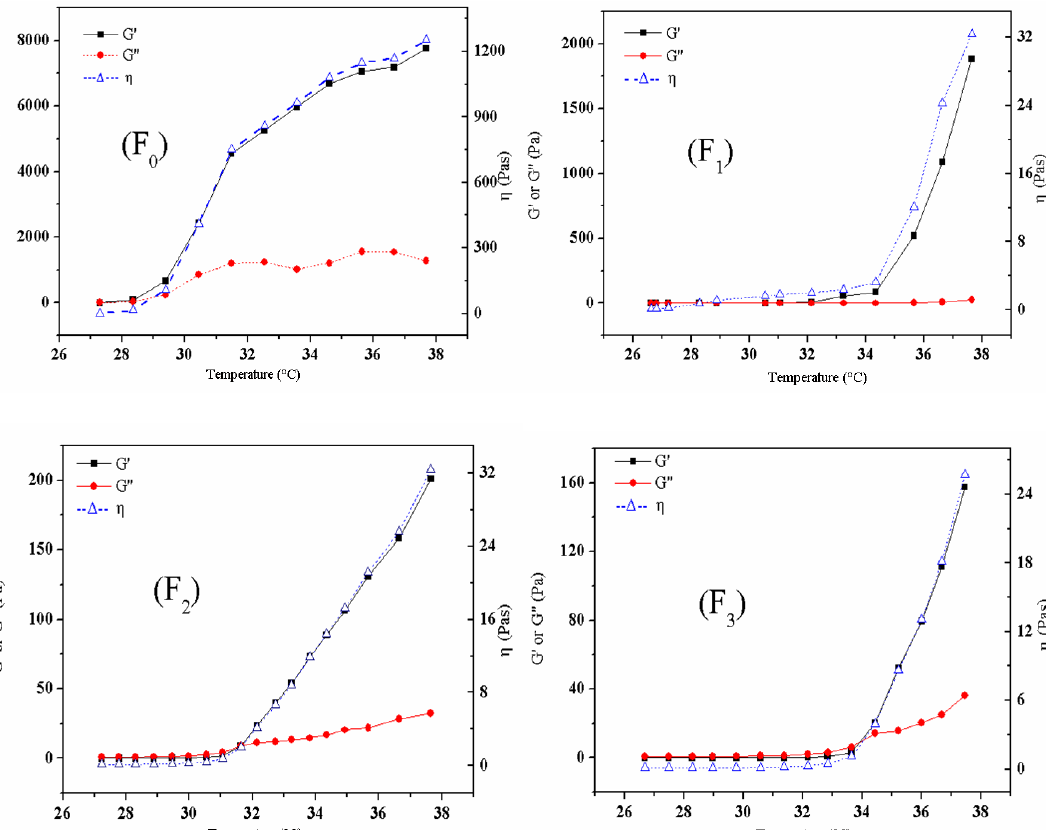
: Thermosensitive composite hydrogel; F : 0 1 : Thermosensitive 2 : Thermosensitive composite hydrogel 3